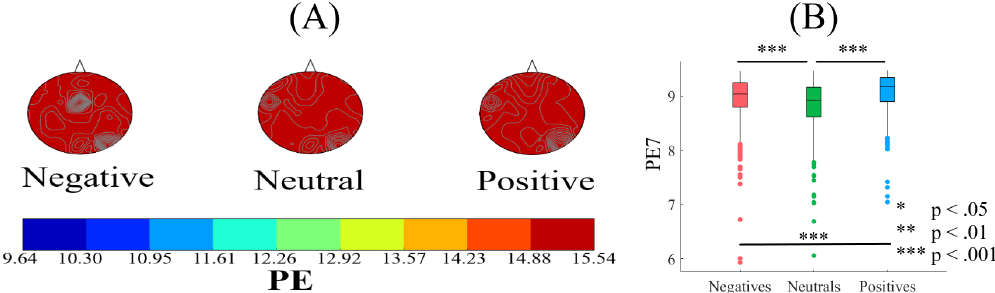
Figure A21. ( A ) Grand averages of the spatial maps of participants’ PE7s (i.e., 62 PE7s associated with 62 EEG channels of a participant, per affect) in negative, neutral, and positive mental states. Distribution of PE7s in these spatial maps corresponds to the EEG channels’ arrangement in Figure 1B in the main text (i.e., one PE7 value, per EEG channel). ( B ) Descriptive statistics of participants’ PE7 in negative, neutral, and positive mental states. The asterisks mark the significant difference in these subplots.